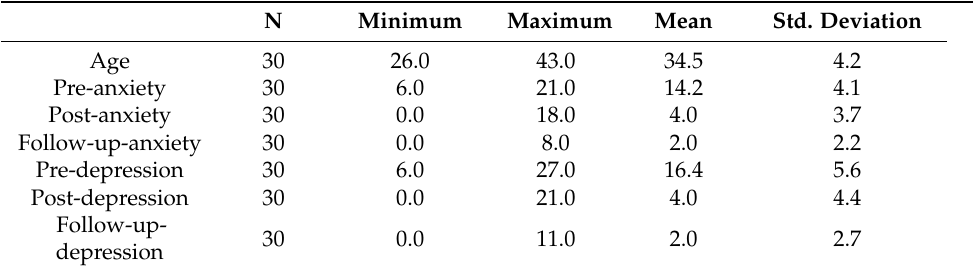
Table 1. Statistics of Age and Anxiety and Depression Scores in Pre-test, Post-test and Follow-up test for 30